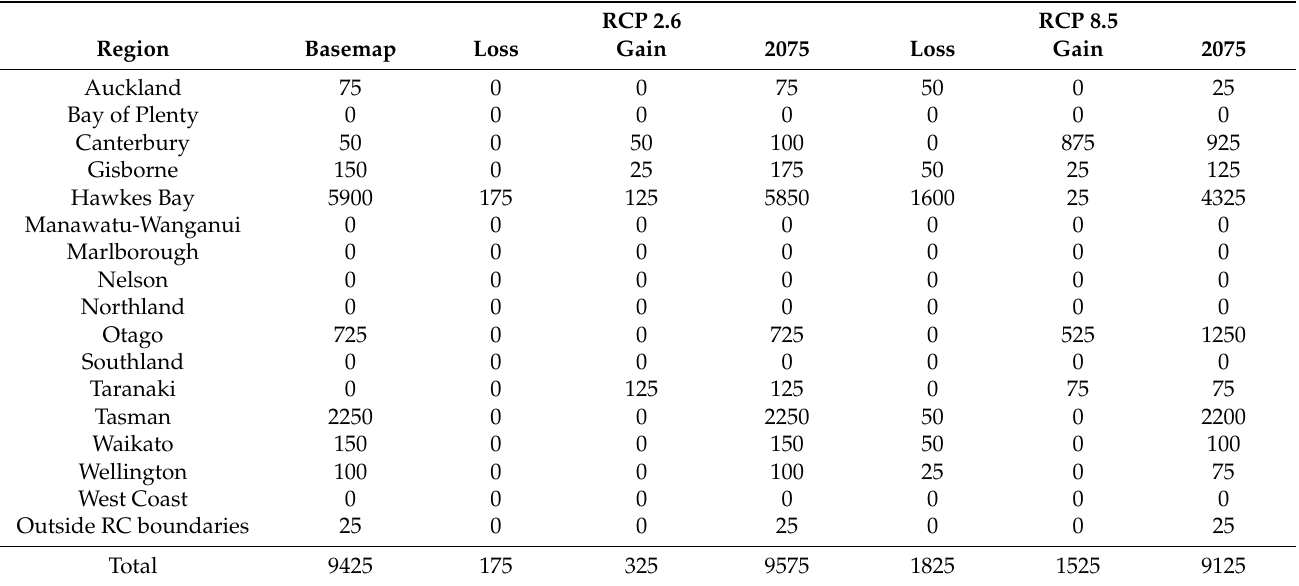
Table 5. Simulated land use (hectares) by region for apples under mild (Representative